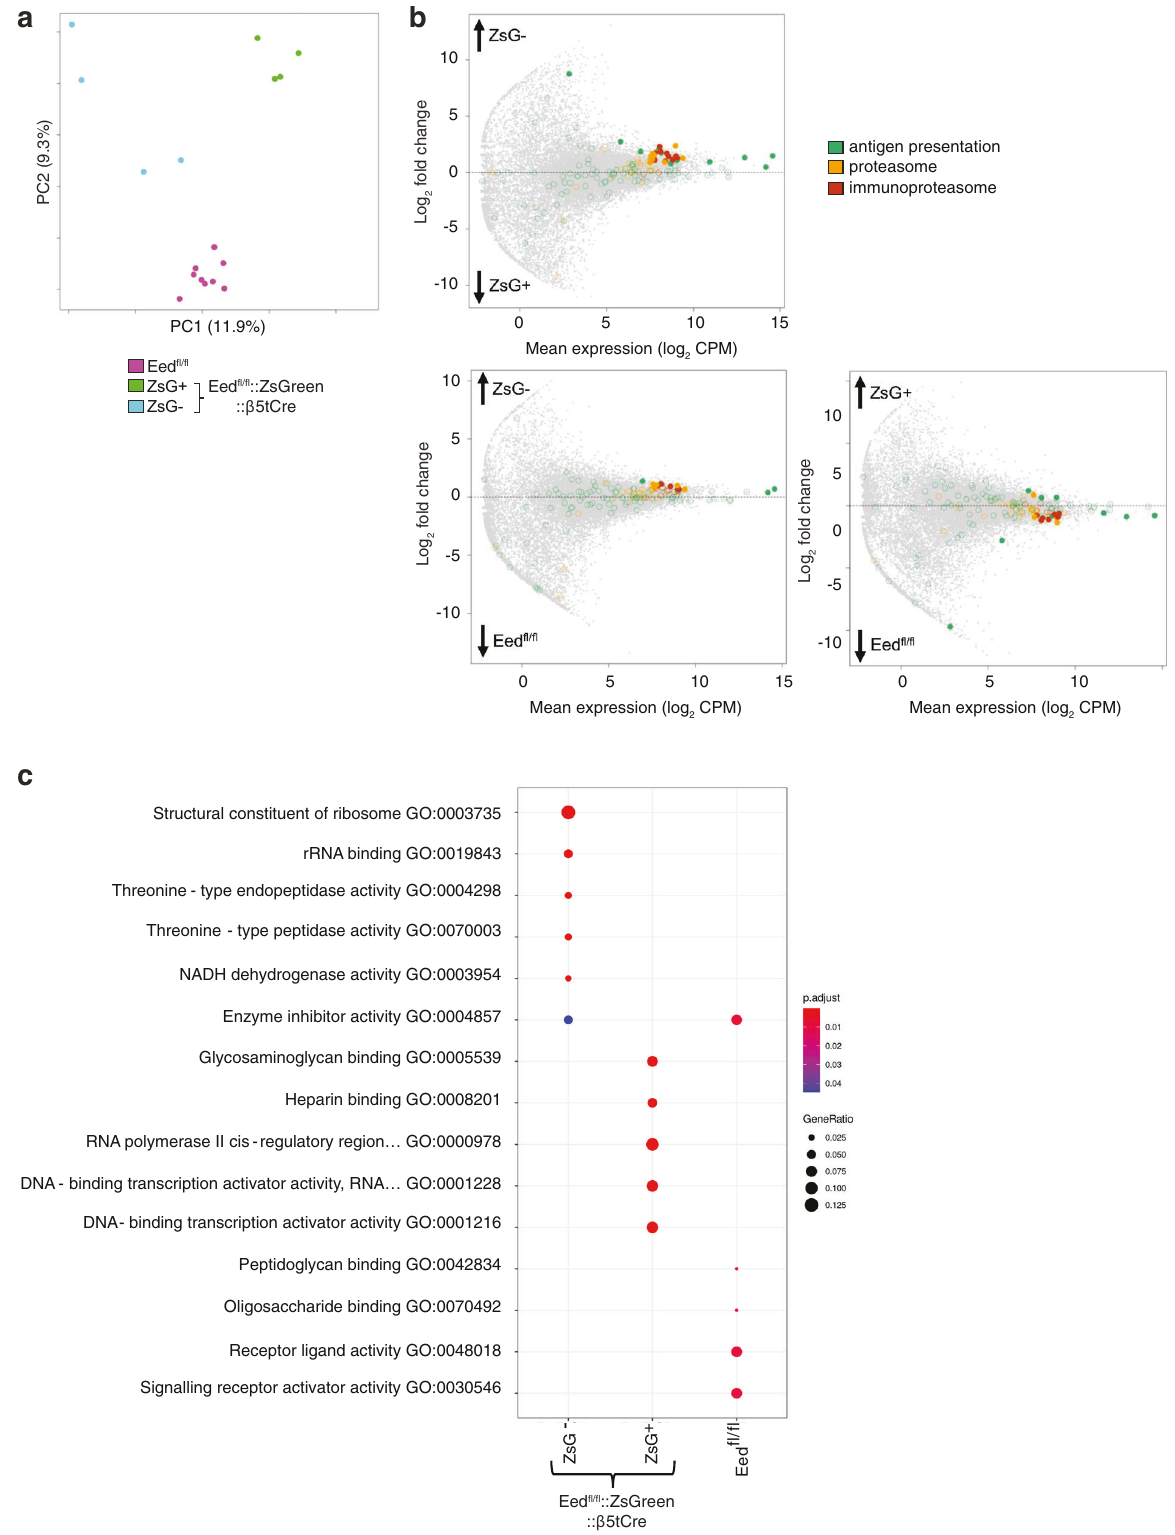
Fig. 8 ZsGreen-positive and -negative mTEC from Eed fl / fl :: ZsGreen :: β 5tCre mice are transcriptomically distinct from mTEC isolated from Eed fl / fl mice. a Principal component analysis of bulk RNA-seq samples. b Scatter plots of differentially expressed genes for each type of mTEC showing genes belonging to gene ontology terms related to antigen presentation and processing (GO:0019882 - green), proteasome (KEGG:03050 - yellow) and immunoproteasome (CORUM:39 - orange). CPM = counts per million. Dashed lines indicate a fold change of 1 and arrows indicate the direction of higher expression. Filled points are signi fi cant at FDR < 0.05. c A dot plot showing signi fi cantly enriched biological pathways within genes signi fi cantly upregulated in each type of